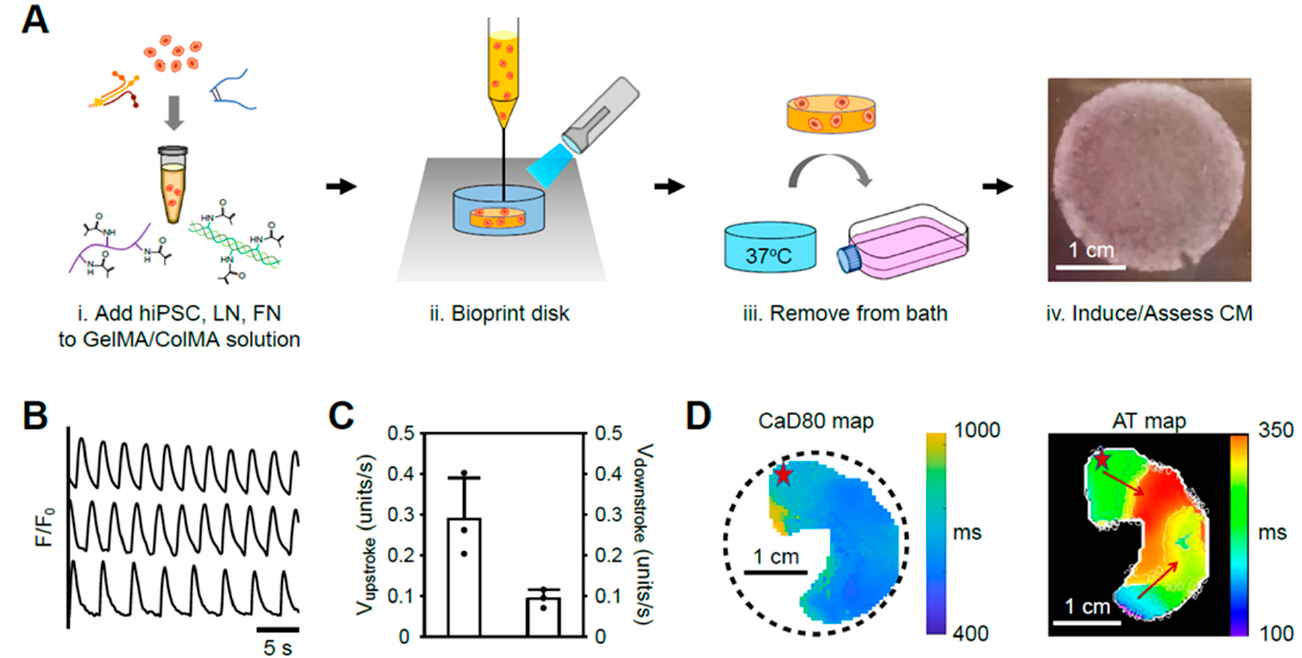
Figure 3. Cardiac disk preparation and characterization. ( A ) Cardiac disks were bioprinted with the bioink composed of human-induced pluripotent cells (hiPSCs) and extracellular proteins. The inset in subfigure iv represents a differentiated cellular disk with a scalpel-made marker for structure orientation. CM indicates cardiomyocyte; ColMA, collagen methacrylate; FN, fibronectin; GelMA, gelatin methacrylate; and LN, laminin-111. ( B , C ) Calcium traces generated from differentiated CMs in 3 different patches and the corresponding calcium upstroke and downstroke velocities. ( D ) Spatiotemporal calcium activity of a disk with 1 Hz pacing including isochronal maps of calcium response duration at 80% of repolarization (CaD80) and the activation time at 50% of depolarization (AT); red asterisks represent the site of pacing.